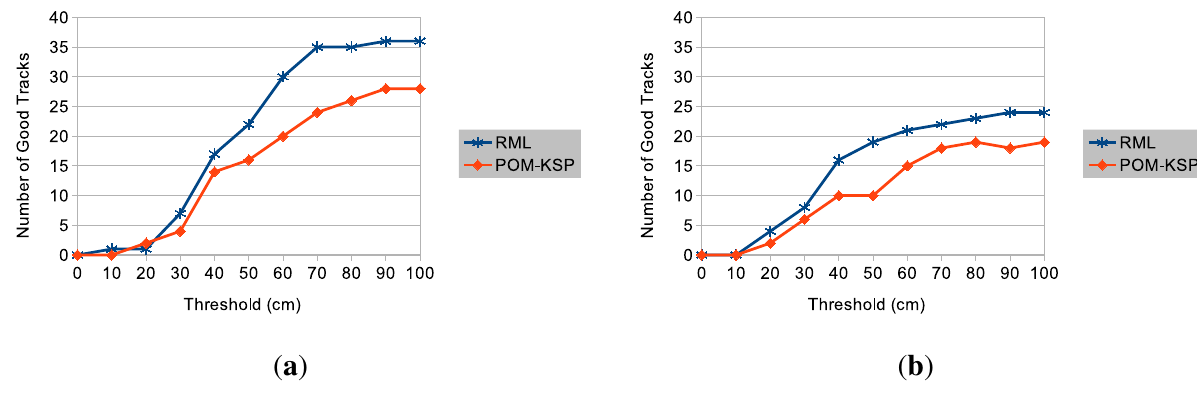
Figure 9. Dependency of the number of good tracks (after mean filtering) on the selected threshold. ( a ) Sequence 1; ( b ) Sequence 2.